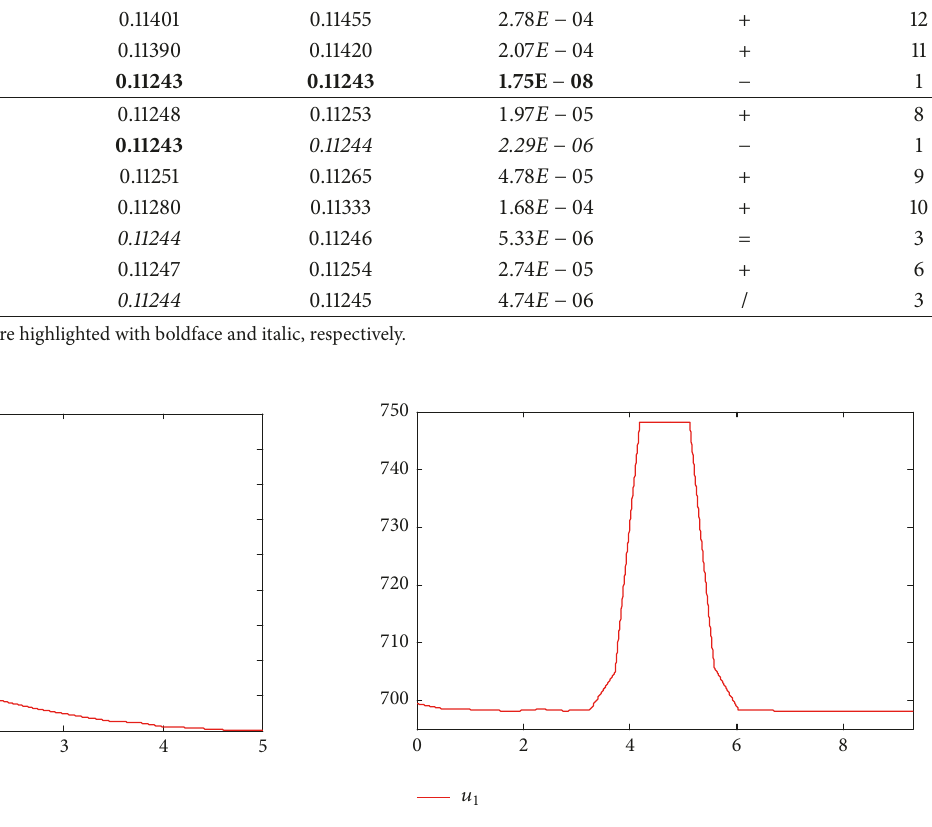
Figure 6: Optimal control for the multimodal CSTR problem. Figure 7: Optimal control for the oil shale pyrolysis